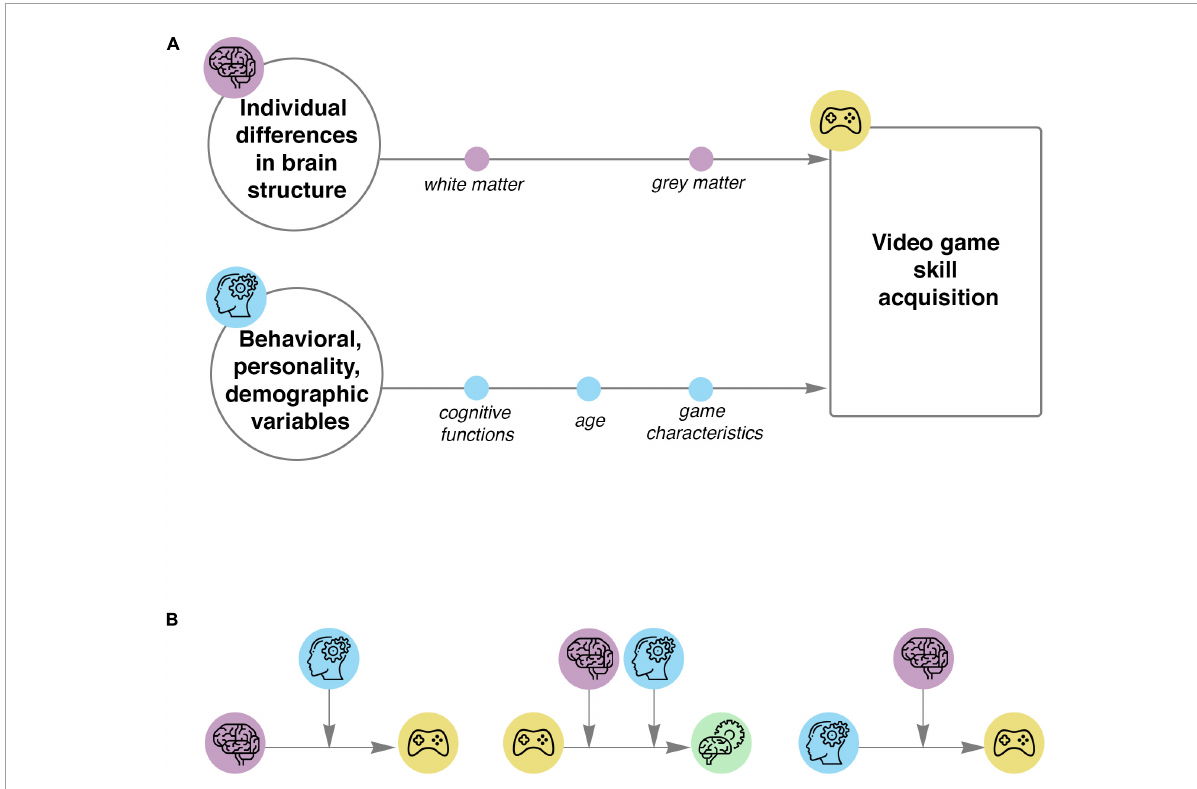
FIGURE3 Models to use in studies of complex VG skill acquisition. (A) Schemas represent the relationship between baseline characteristics and VG skill acquisition. The first schema represents structural predictors of VG skill acquisition. The second schema shows behavioral, personality, demographic and game predictors of VG performance. (B) Proposed complex models of VG skill acquisition using moderation and mediation variables. On the left: baseline structure predicts VG skill acquisition, while behavioral, personality and demographic variables influence the initial relationship. In the middle: relationship between the VG training and neural plasticity, moderated by baseline individual differences in brain structure and behavioral, personality as well as demographic variables. On the right: individual differences in behavioral, personality and demographic characteristics predict VG performance, and baseline structural measures influence the initial relationship. Icons were obtained from